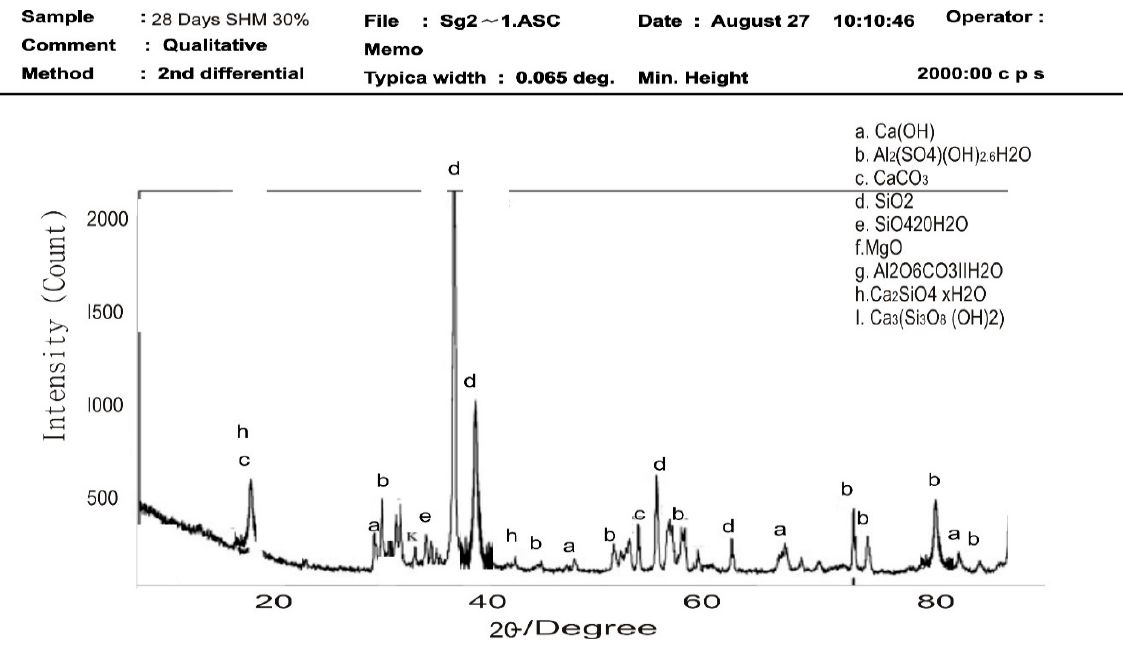
Figure 13. XRD pattern of the SPM-30 sample at 28 days .